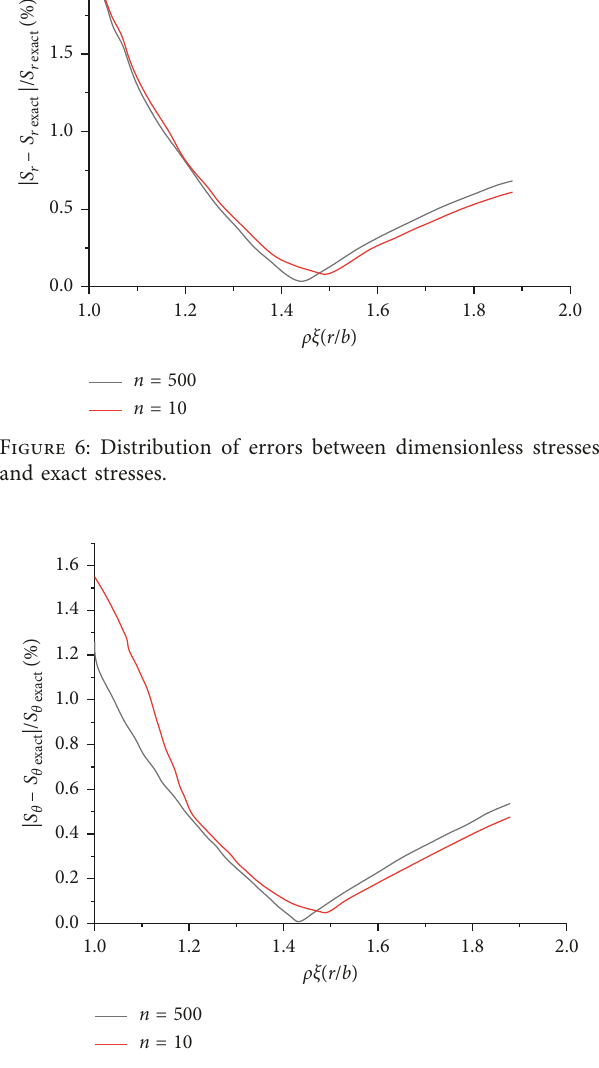
Figure 7: Distribution of errors between dimensionless dis- placement and exact displacement.